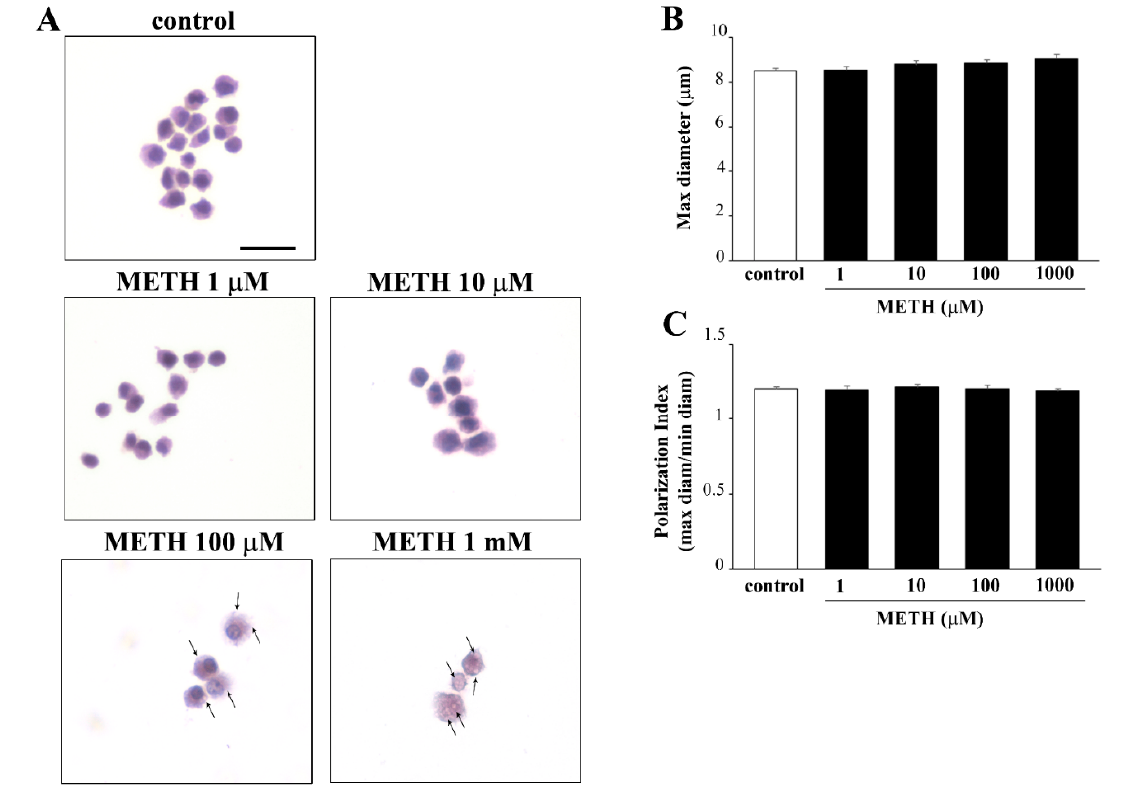
Figure 9. Dose-dependent METH-induced morphological changes in PC12 cells. ( A ) Representative pictures of H&E-stained PC12 cells after METH administration. Cytosolic pale vacuoles (arrows). ( B ) Graph reports the maximum cell diameter and the Polarization Index ( C ). Scale bar = 24.3 μ M .